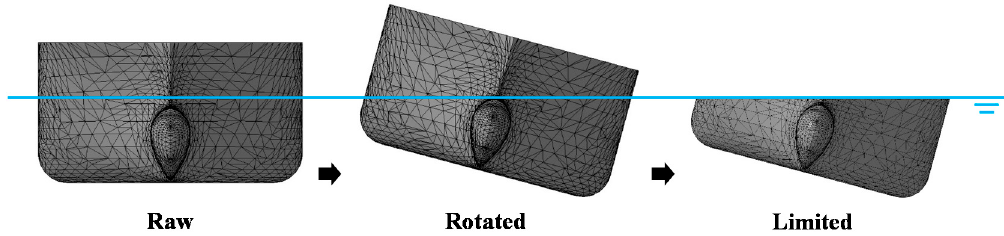
Figure 8. Rotated model slicing.